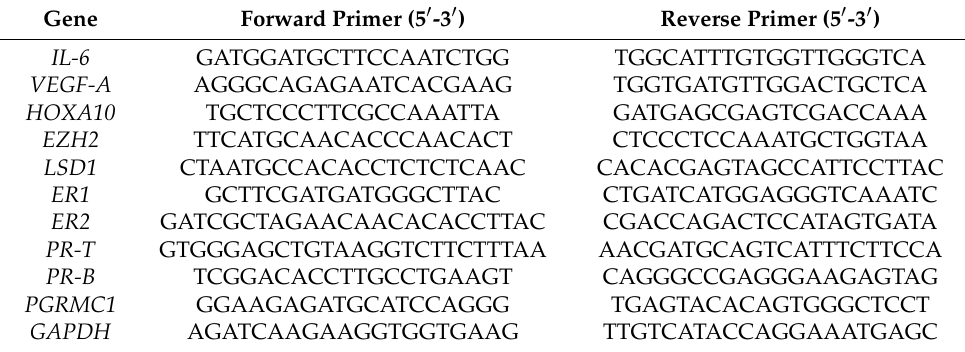
Table 1. Primers used for RT-qPCR.